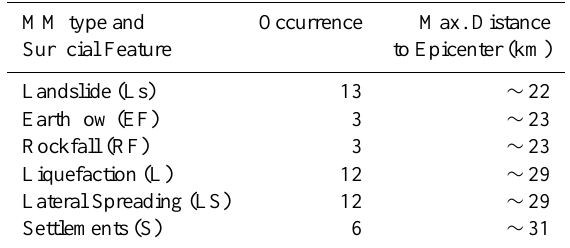
Table 3. Occurrences and maximum distances to the earthquake epicenter of the mass movements and surficial